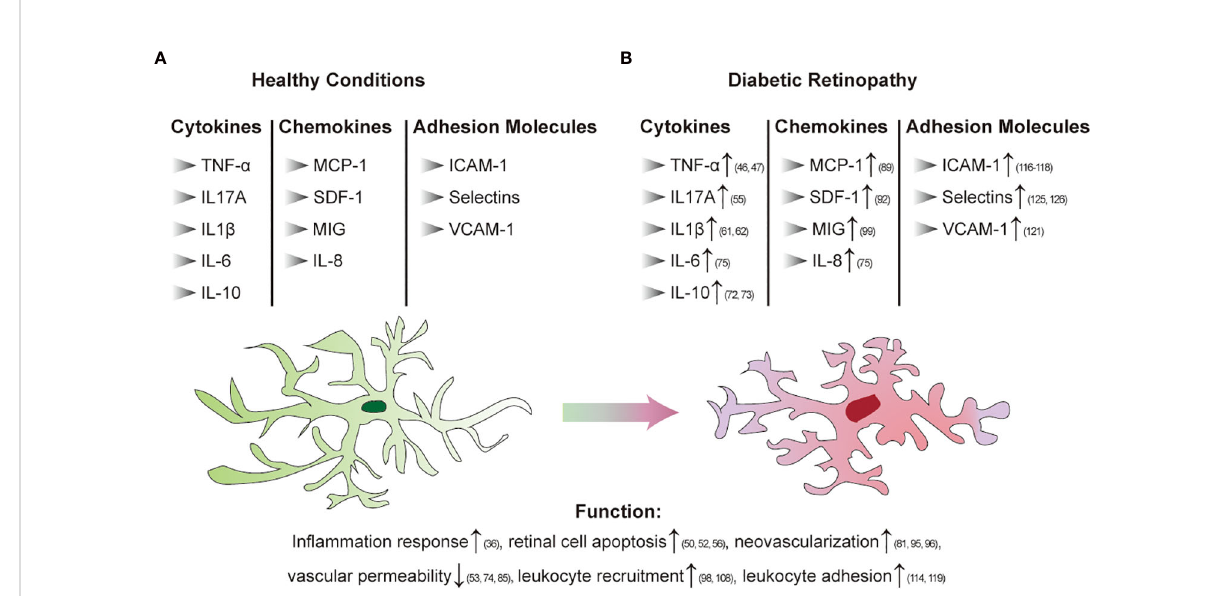
FIGURE 2 Immune regulation in diabetic retinopathy [ (A) : Healthy conditions; (B) DR]. Arrows indicate elevated levels or increased